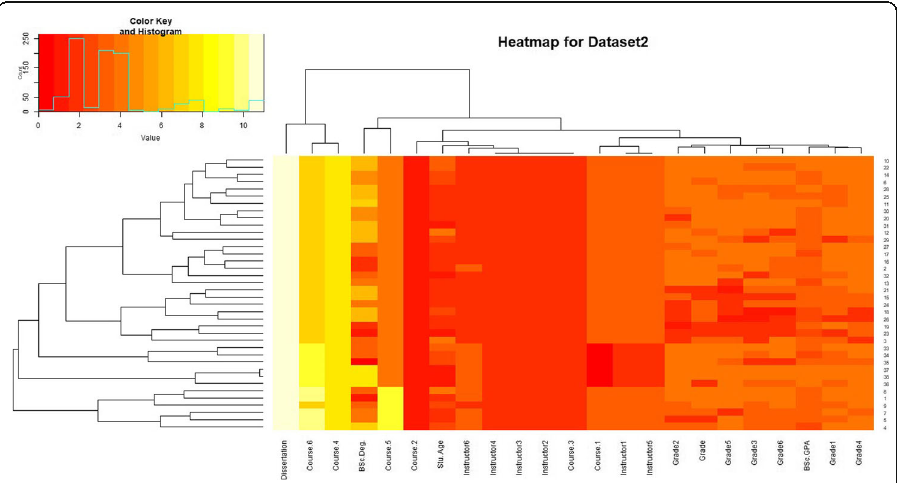
Fig. 3 The dataset2 after the new attributes creation and